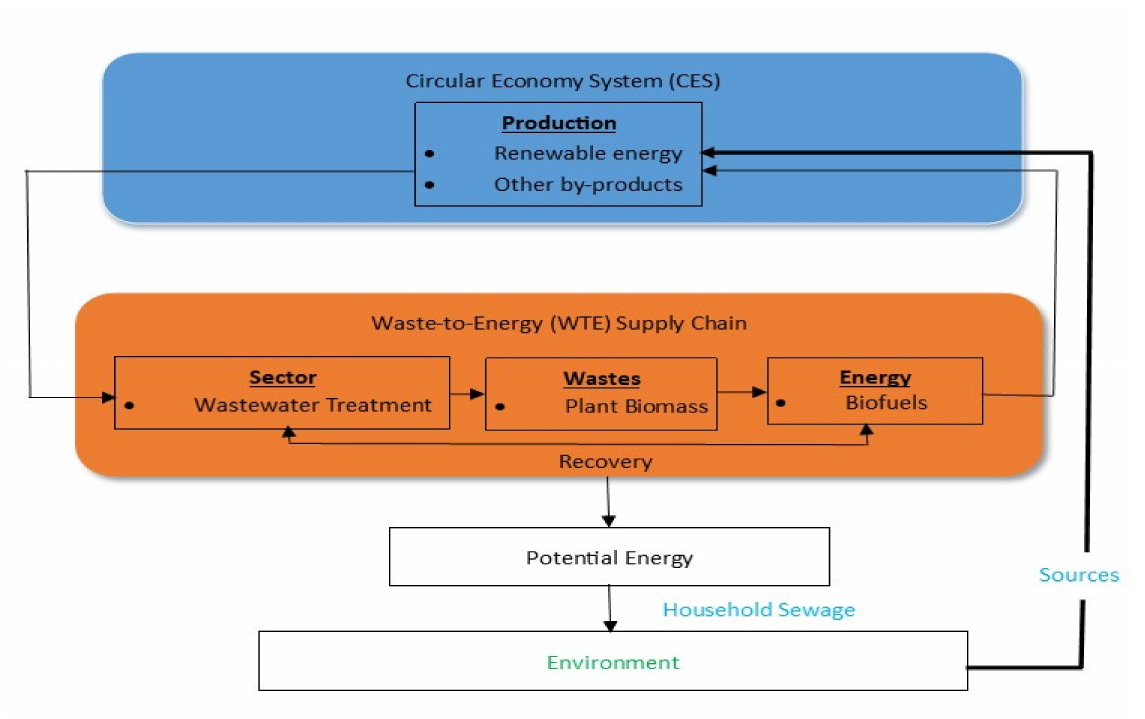
Figure 3. Relationship between CE, waste-to-energy and environment framework for phytoremedia- tion of domestic